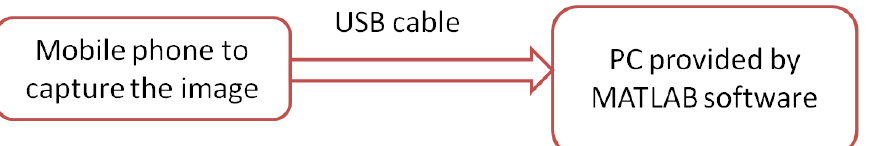
Figure 11. The proposed system.